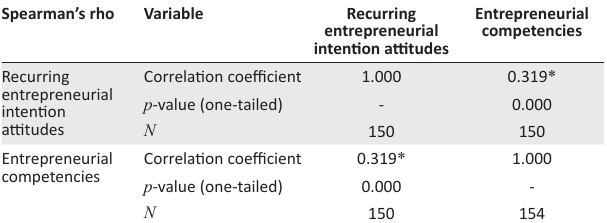
TABLE 5: Results of Spearman’s rank-order correlation.